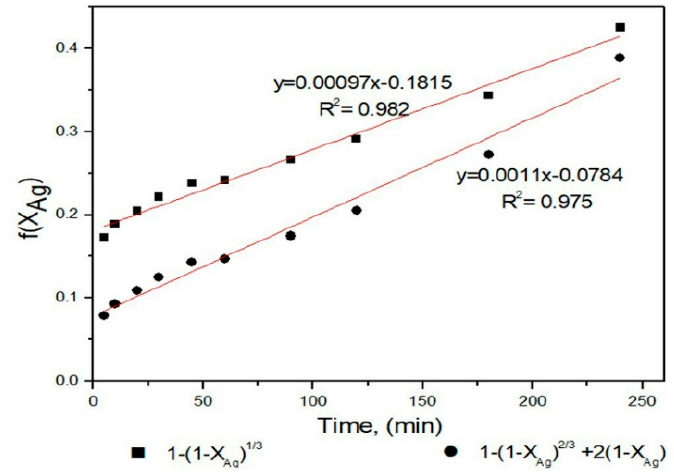
Figure 6. Comparison between the chemical control model and the control-by-transport model for the leaching of silver in the S 2 O 32 − -Cu 2+ system .